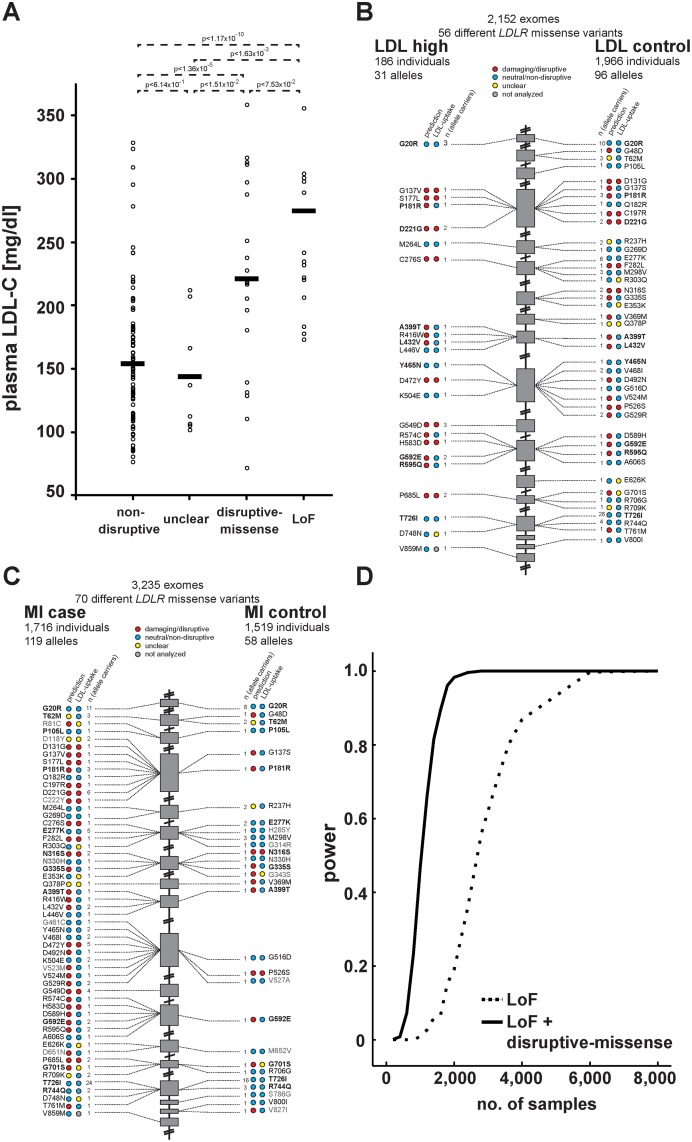
Functions and distribution of LDLR rare missense alleles identified through exome sequencing of 3,235 individuals.
(A) Plasma LDL-C (in mg/dl) in LDLR missense allele carriers (dots) from the ATVB cohort according to functional category (for classification, see Methods). LoF, loss-of-function. Means are indicated by horizontal bars. p-value was determined by 2-sided, 2-tailed Student’s t-test. (B, C) Individual LDLR missense variants identified through exome sequencing of indicated number of individuals are depicted according to genomic position starting at the 5’end (top). The numbers next to each variant represent the number of times the respective variant was observed in cases and controls, respectively, with regard to plasma LDL-C levels (b) and early-onset myocardial infarction (MI; c). Colors in circles represent indicated functional classes as determined either by an overlap of four bioinformatic prediction tools (PolyPhen-2, SIFT, MutationAssessor and MutationTaster; see Methods) (“prediction”) or cell-based experimental studies of LDL-uptake. Variants in bold have been observed in both, cases and controls. (D) Power calculations for the number of sequenced individuals needed to reach exome-wide significance (p<2.5×10-6, reflected by power = 1) for association with MI-risk when the indicated classes of rare LDLR alleles are taken into account. For details, see Methods.